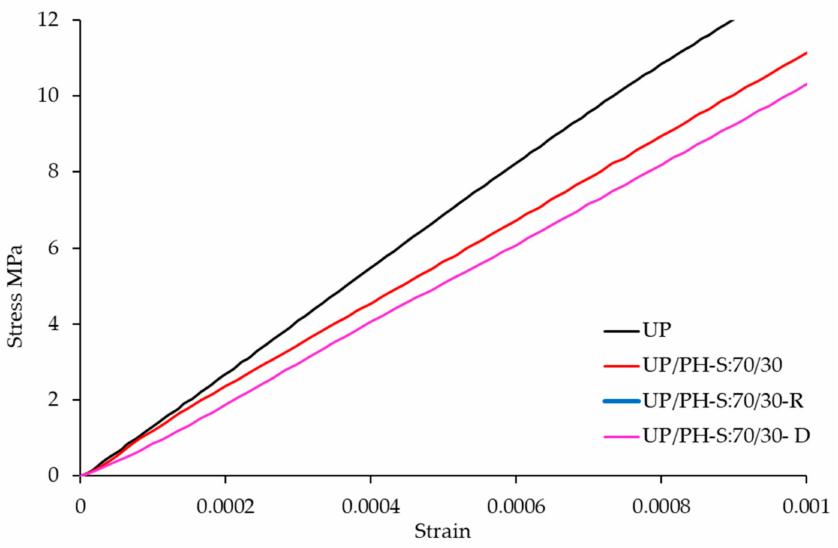
Figure 5. Stress vs. strain curves for GFRC of UP and UP/PH-S:70/30 with FRs under flexural